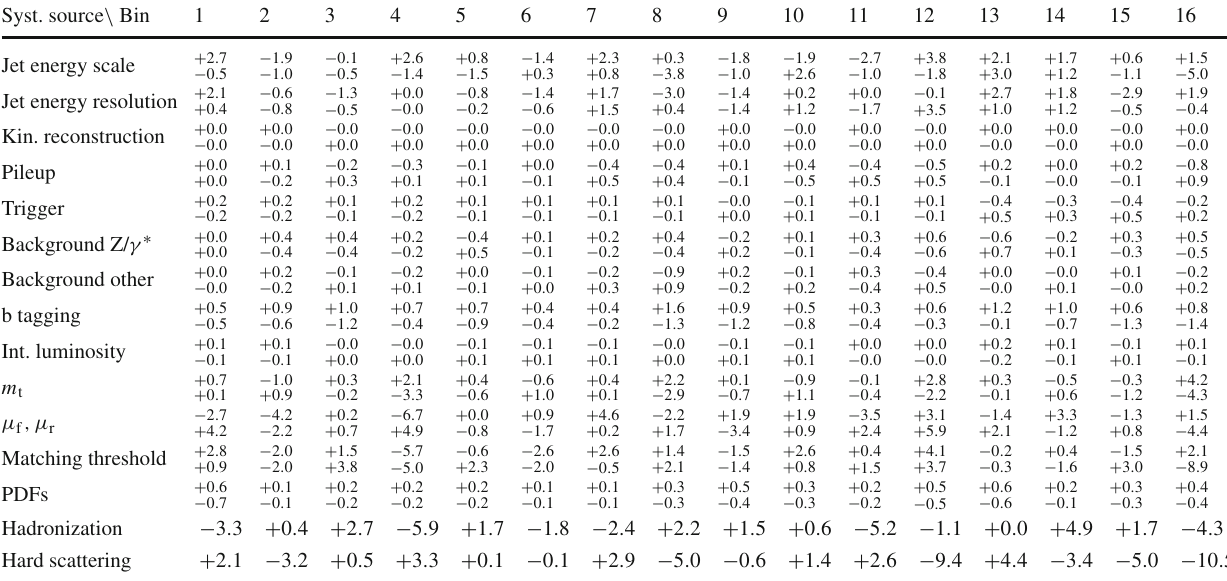
Table 7 Sources and values of the relative systematic uncertainties in percent of the measured normalized tt double-differential cross sections as a function of y ( t ) and p T ( t ) . For bin indices see Table 5